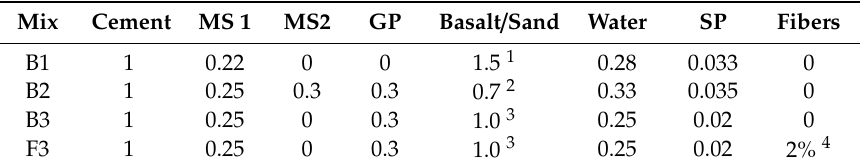
Table 2. Own mixture